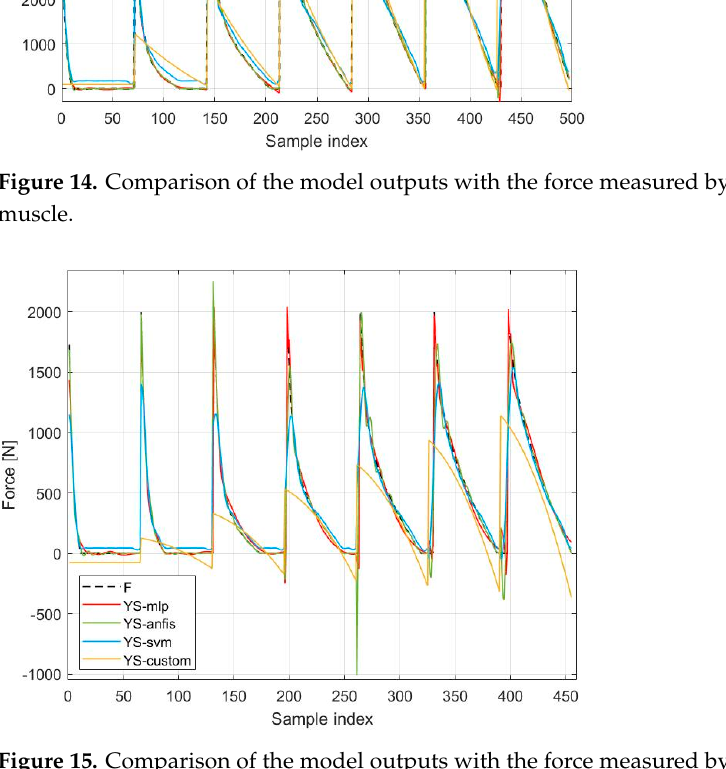
Figure 15. Comparison of the model outputs with the force measured by FESTO for the DMSP − 20 muscle. A comparison of the outputs of the best models in one graph, together with the ex- perimentally obtained data for the DMSP − 5 muscle, is shown in Figure 16. The measured tensile force is indicated by a black dashed line labeled F . The outputs of the individual models are shown by solid colored lines: